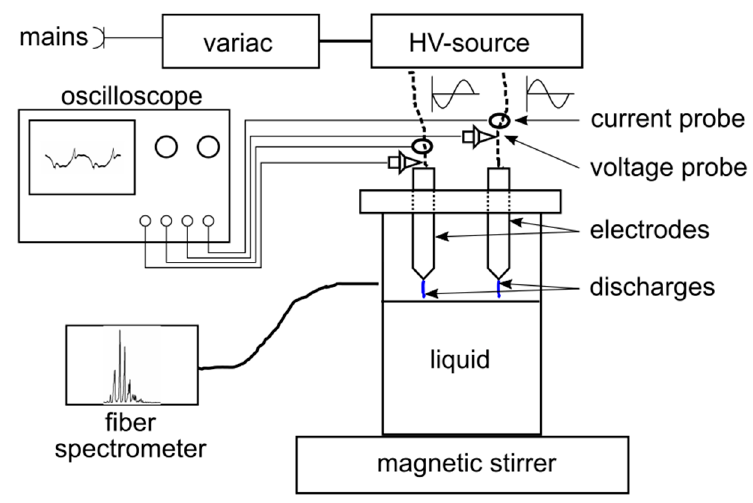
Figure 1. Experimental setup.